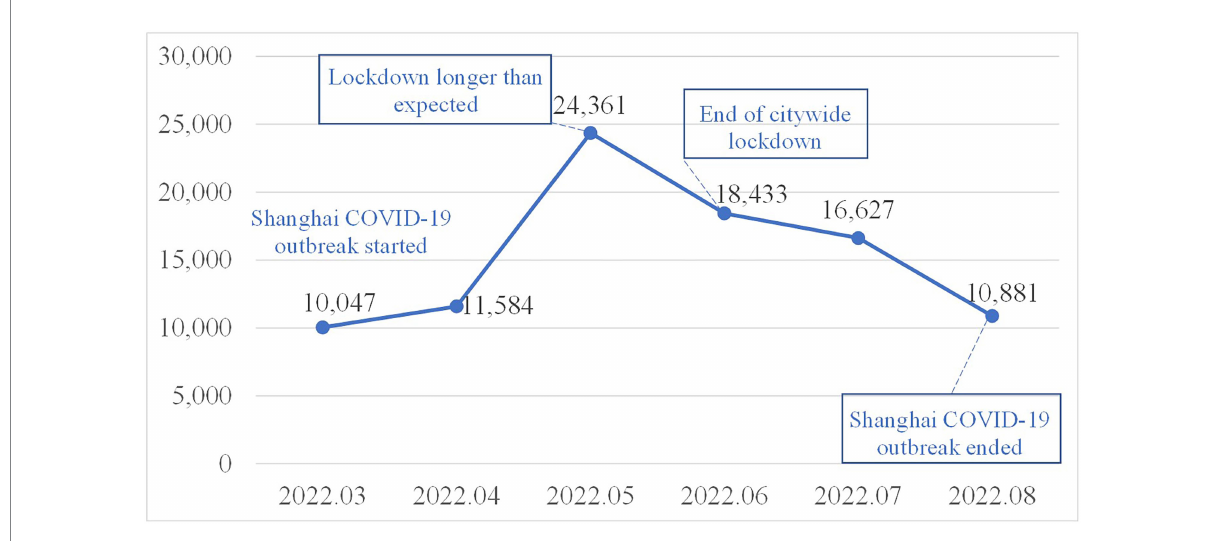
FIGURE 2 Total number of Weibo posts from March 2022 to August